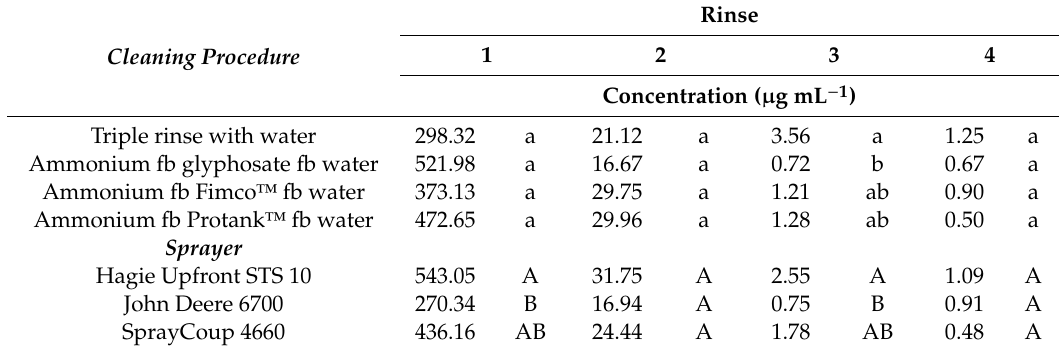
Table 4. Dicamba concentrations in rinsates following cleanout procedures in di ff erent sprayers A,B,C,D